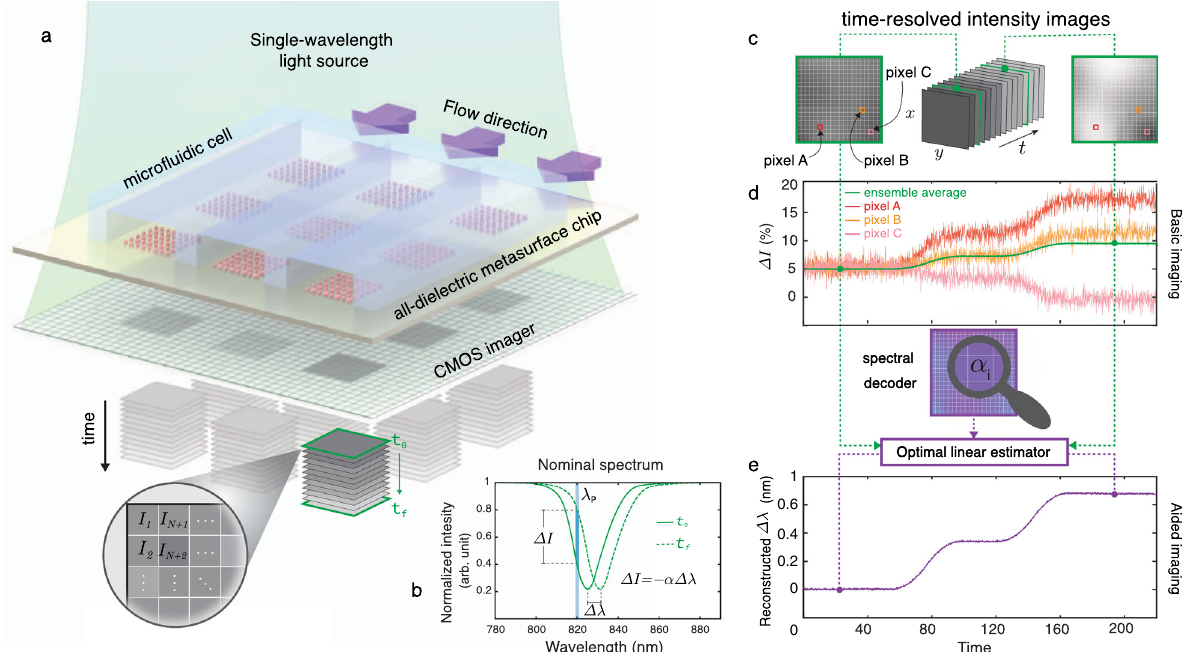
Fig. 1 Principles of the single-wavelength algorithm-aided imaging biosensor with spectral shift reconstruction and its advantages over the basic imaging approach that merely relies on the intensity change. a Sketch of a real-time in- fl ow imaging platform showing a 2D microarray of all-dielectric sensors integrated with a micro fl uidic cell consisting of three independent fl ow channels. The metasurface chip is illuminated with a single-wavelength light source and imaged with a large-area CMOS camera to acquire intensity maps of the sensors in pixel resolution ( I 1, I 2 , … , I N + 1 , I N + 2 , … ). b Biomarker binding induces a red-shift in the transmission spectrum ( Δ λ ), which can be detected by tracking the resonance wavelength or by the intensity change ( Δ I ) at a fi xed probing wavelength ( λ Δ I can be approximated as linearly proportional to Δ λ with a constant of α , which is the slope of the transmission spectrum p ). in the linear region near λ p . c Pictorial representation of time-resolved single-wavelength intensity images. d The illustration represents the shortcomings of the basic imaging approach. Time-resolved intensity data from single pixels (A, B, and C) from the sensor area give contradicting responses with noisy signals (red, orange, and pink curves) due to the nonuniformities. Ensemble averaging of the responses from multiple pixels can help to decrease the noise, although it may reduce the fi nal signal, as depicted with the green curve. e The illustration represents the implementation and the advantages of our aided imaging approach. By leveraging the optimal linear estimator algorithm and the spectral decoder that incorporates the 2D map of the slope values, time- resolved single-wavelength intensity images are used to reconstruct robust spectral shift ( Δ λ ) information dynamically (purple